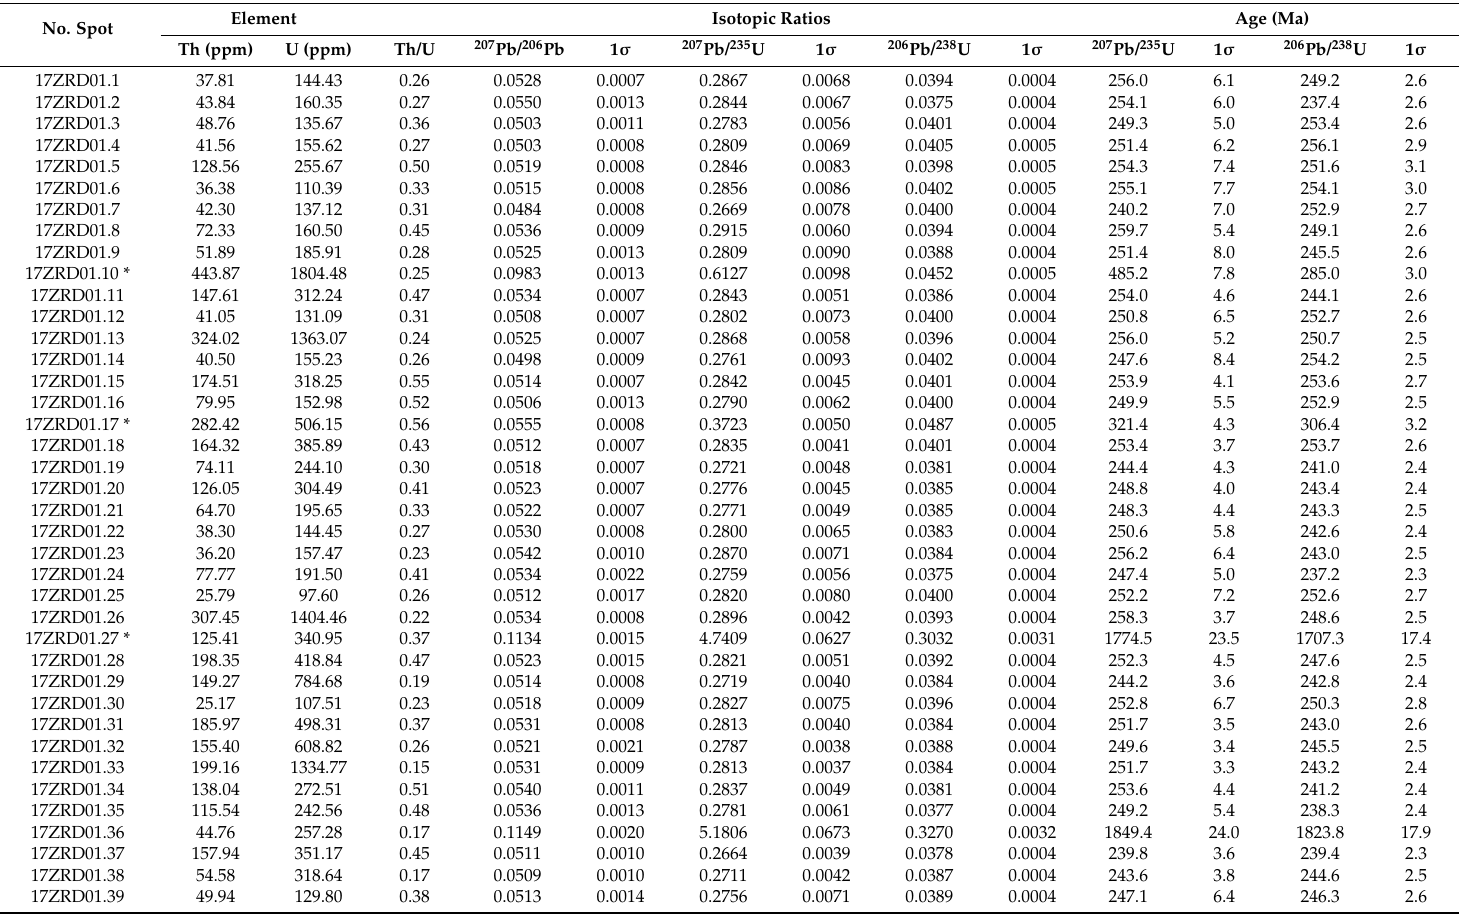
Table 2. Zircon LA-ICP-MS U–Pb data of the ore-hosting diorite in the Zaorendao